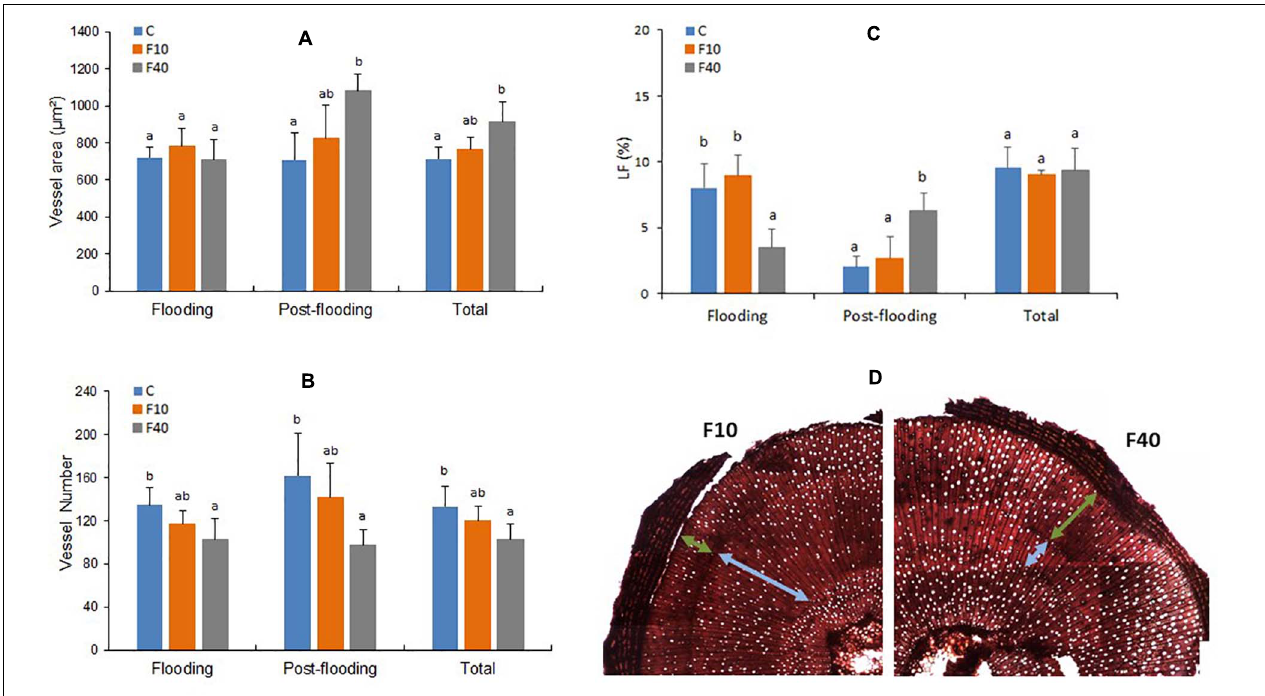
FIGURE 6 | Vessel area (A) , vessel number (B) , percentage of vessel lumen fraction of the stem (LF, C ), transversal cut of the stem with light blue arrows indicating the vessels developed during flooding, and green arrows indicating the vessels formed during post-flooding (D) . Total refers to the average values of all vessels in the stem (formed during pre-flooding, flooding and post-flooding). Means followed by the same letter did not differ according to Tukey’s test ( p < 0.05, N = 5). Vertical bar: standard deviation.